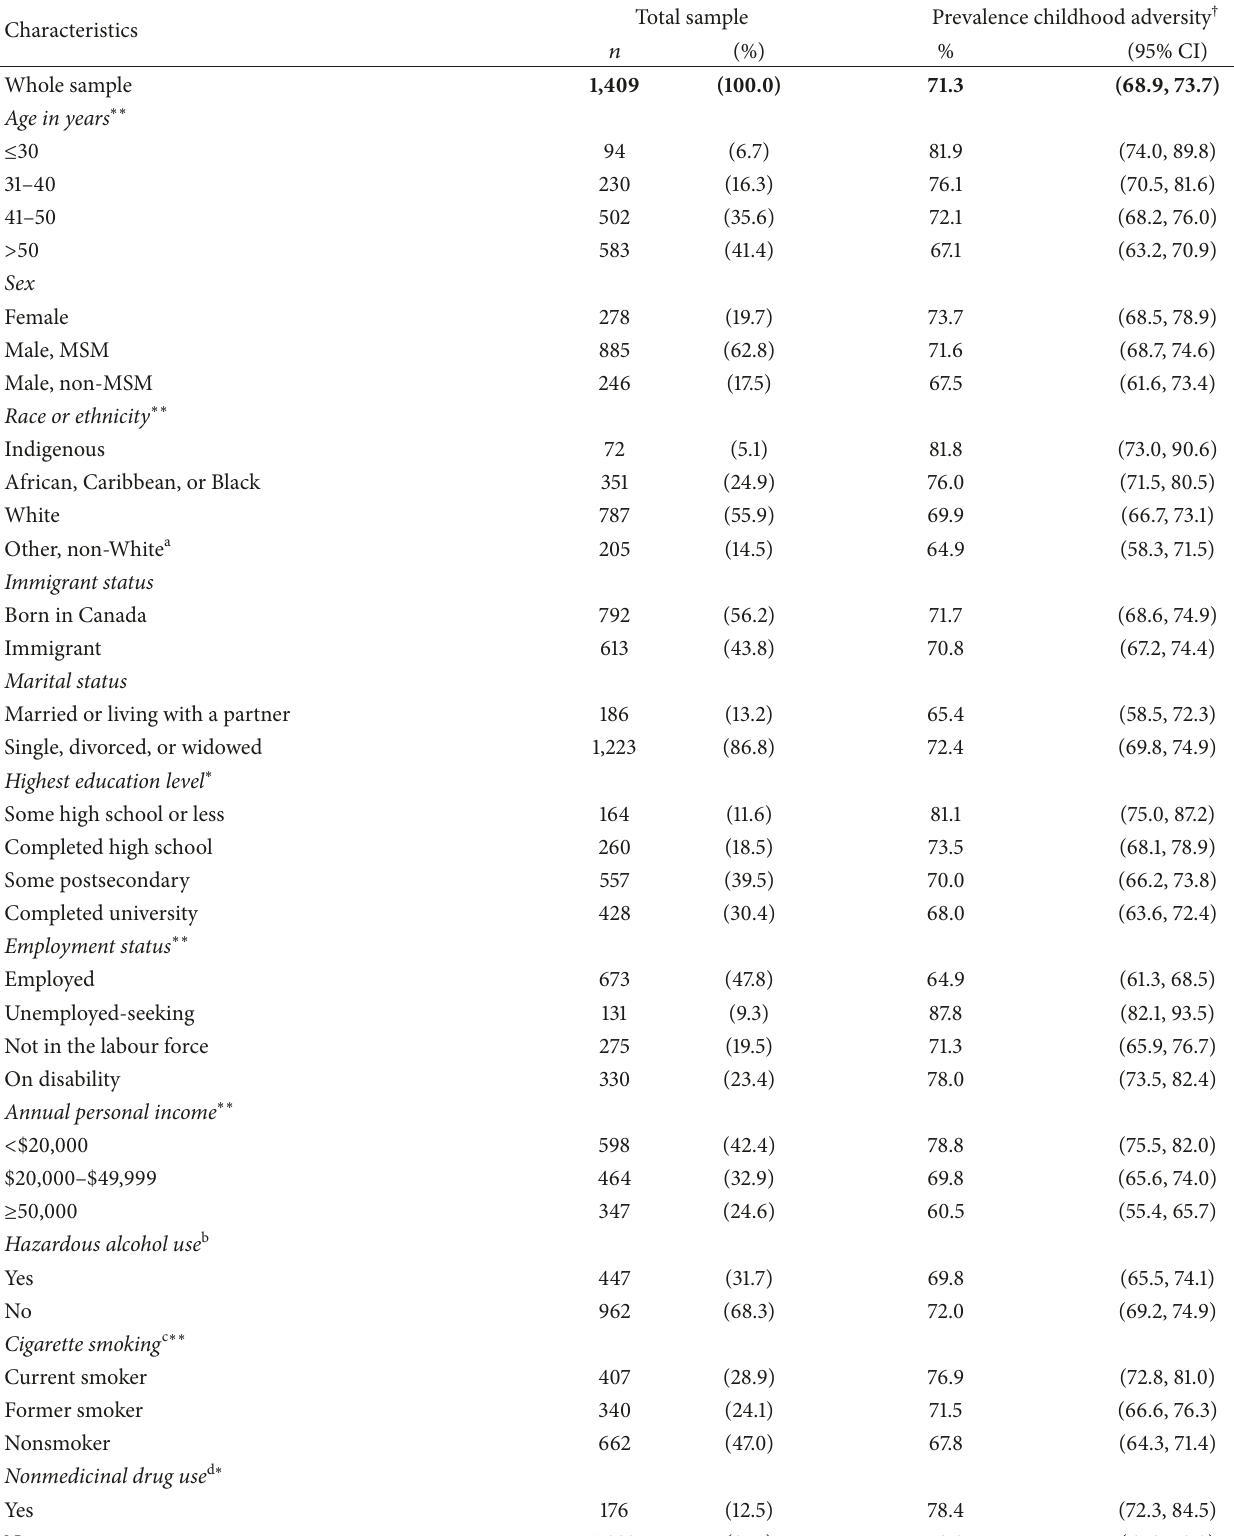
Table 1: Sample characteristics and prevalence of childhood